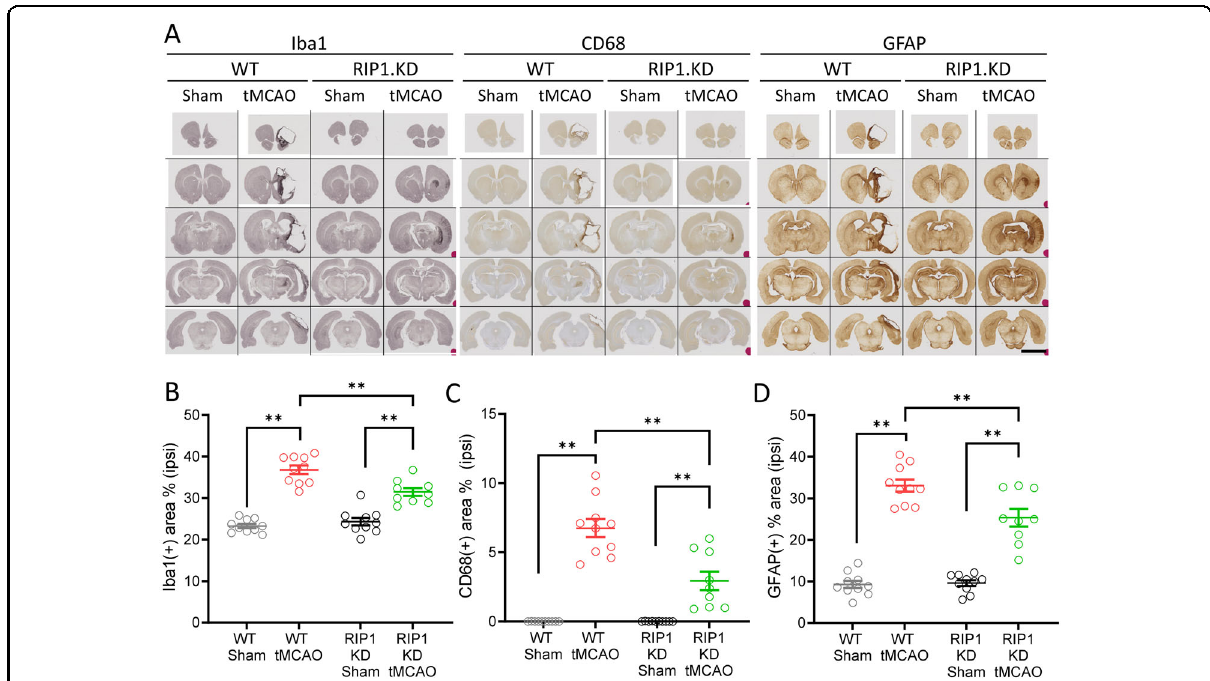
Fig. 4 Genetic inactivation of RIP1 kinase activity reduces in fl ammation following ischemic brain injury. A Immunohistochemistry for Iba1, CD68, and GFAP in WT and RIP1 KD rats at 30-days post-tMCAO. Representative images across the brain are shown. Scale bar, 5mm. B – D Quanti fi cation of percent tissue area positive for high-intensity Iba1 ( B ), CD68 ( C ) and GFAP ( D ) in the ipsilateral side, from ( A ). n = 8 – 10 rats/group. ** p <0.01 by Two-way ANOVA (Holm-Sidak). Data are represented as